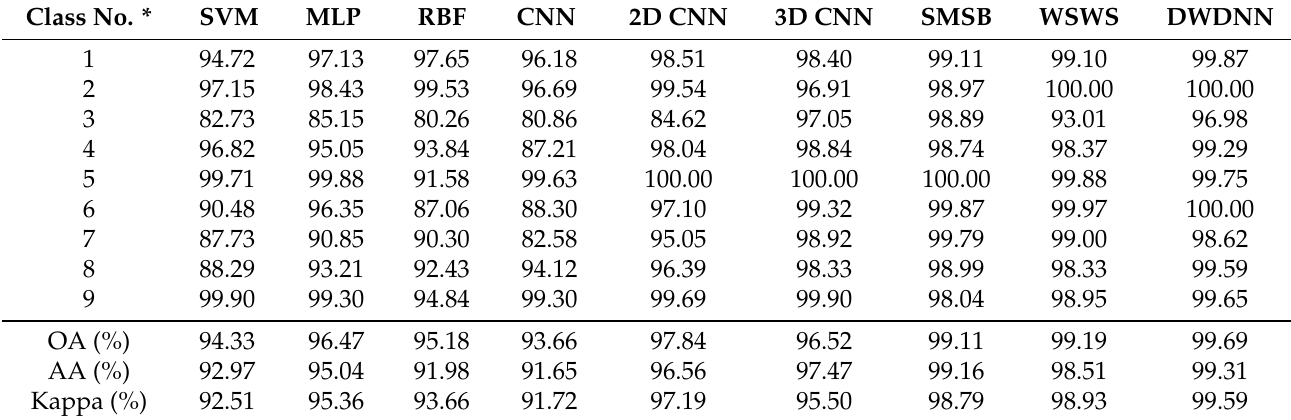
Table 4. Classification results of different methods on the Pavia University dataset.